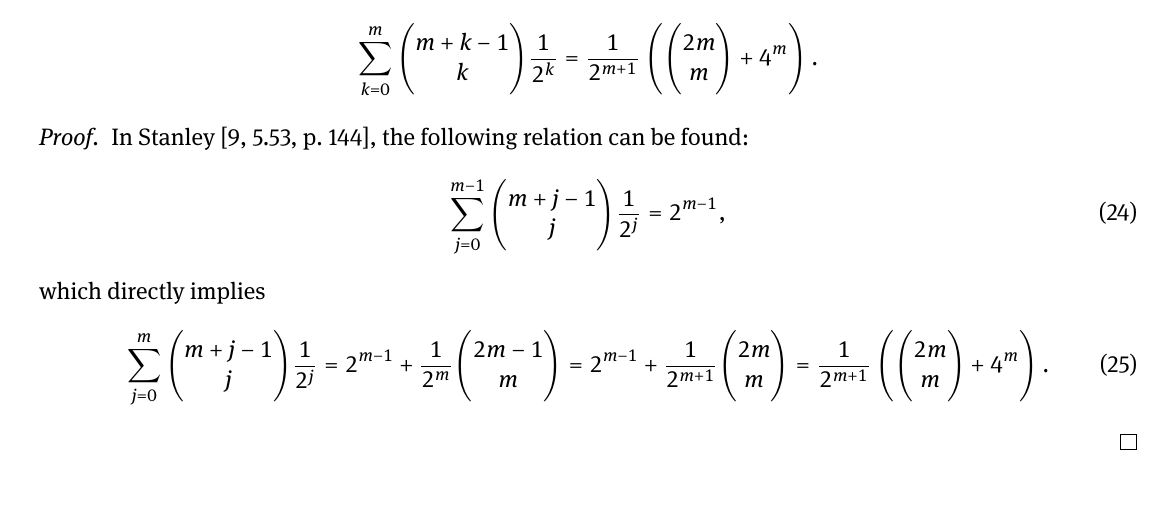
c NB a ,sing ( u , v ) , a = 1 Figure 5: Ratio Figure 4: Ratio c Γ a ,sing ( u , v )